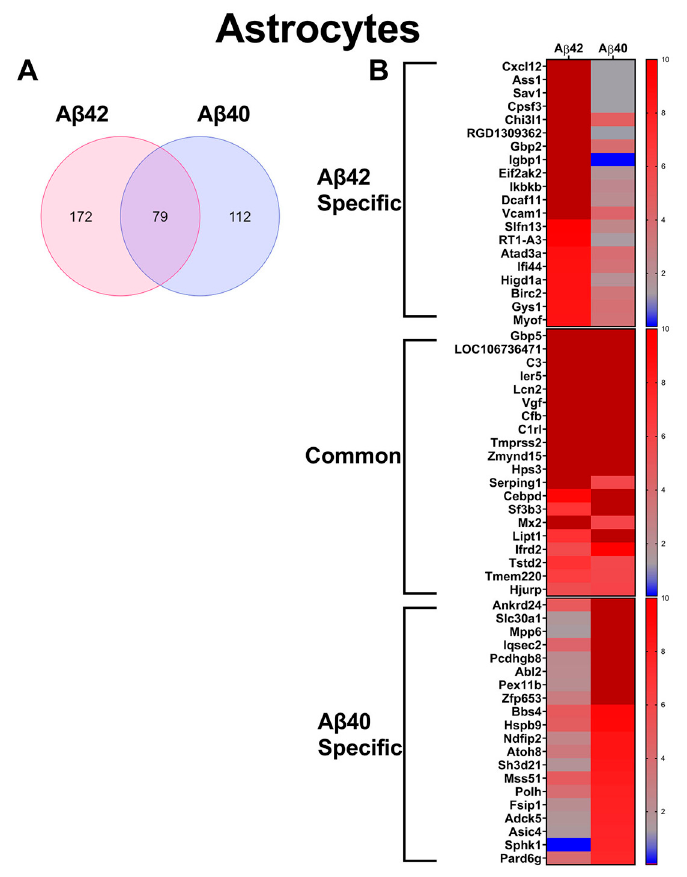
Figure 4. Significantly increased genes in primary astrocytes treated with A β 42 or A β 40 fibrils. ( A ) Venn diagram comparing significantly ( p < 0.05) up-regulated genes, >5-fold of untreated controls, in primary astrocytes treated with A β 42 or A β 40 fibrils ( n = 3). ( B ) Heat maps depicting relative expression of most enhanced genes specific to A β 42 fibril treatment, common to both A β 42 or A β 40 fibril treatments and specific to A β 40 fibril treatment, together with the corresponding expression in the other treatment groups.